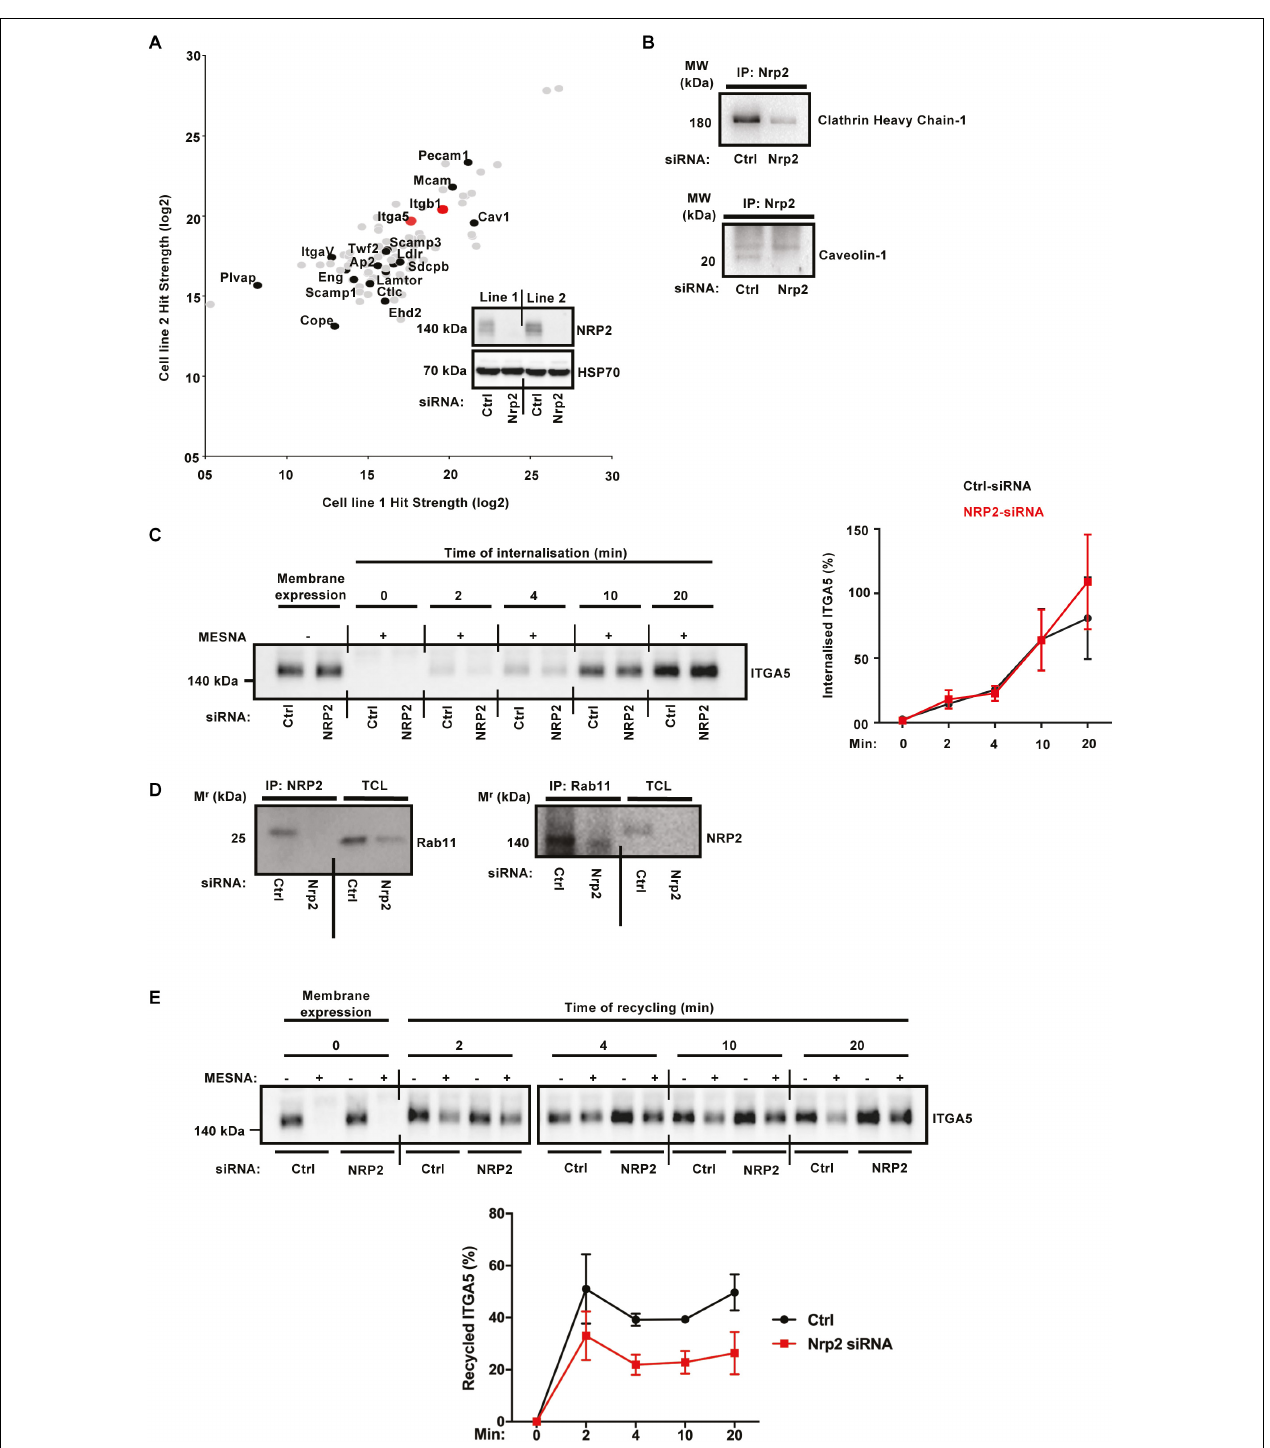
FIGURE 4 | ITGA5 trafficking in ECs is NRP2 dependent. (A) : Label-free quantitative mass spectrometry peptide hits identified using MaxQuant software from the Andromeda peptide database. Panel depicts peptide hits detected at a higher fold-change in two control siRNA treated EC lines than those detected from two NRP2 siRNA treated EC lines. NRP2 silencing was confirmed by subjecting EC extracts to Western blot analysis. (B) : siRNA-transfected ECs were seeded onto FN and incubated for 48 h. EC extracts were immunoprecipitated by incubation with protein-G Dynabeads R (cid:13) coupled to a NRP2 antibody. Immunoprecipitated complexes were subjected to Western blot analysis using antibodies against clathrin heavy chain-1 (top) and caveolin-1 (bottom). (C) : siRNA-transfected ECs were seeded onto